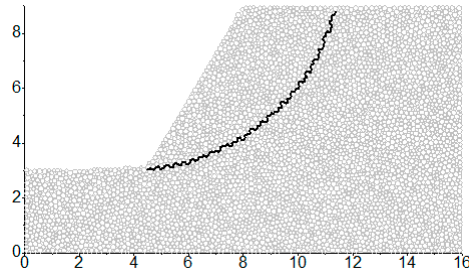
Figure 10. The edge sequence which characterizes the sliding surface.